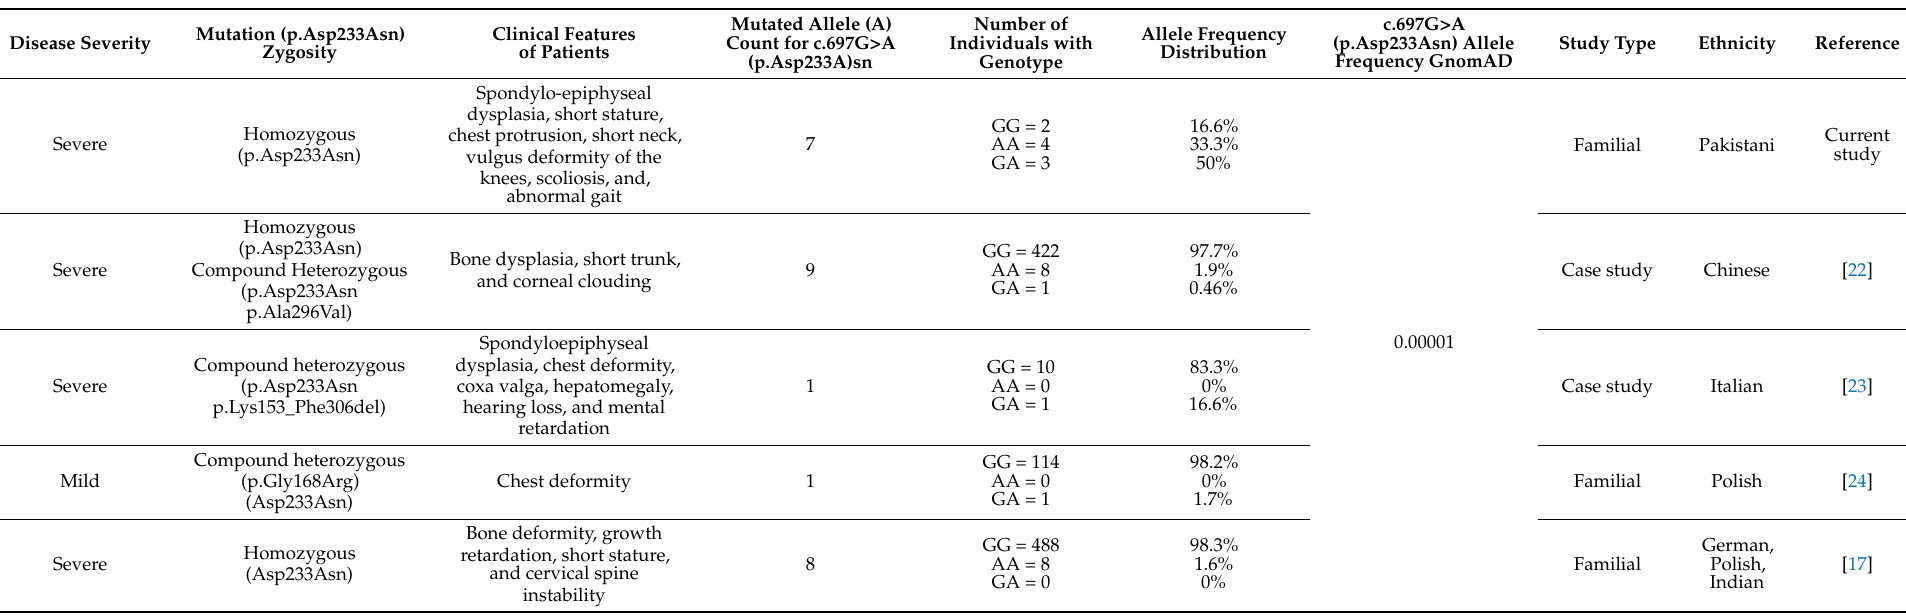
Table 1. Current study and reported patients worldwide with GALNS mutation (p.Asp233Asn) where genotype GG is wild type, AA is homozygous mutant and GA is